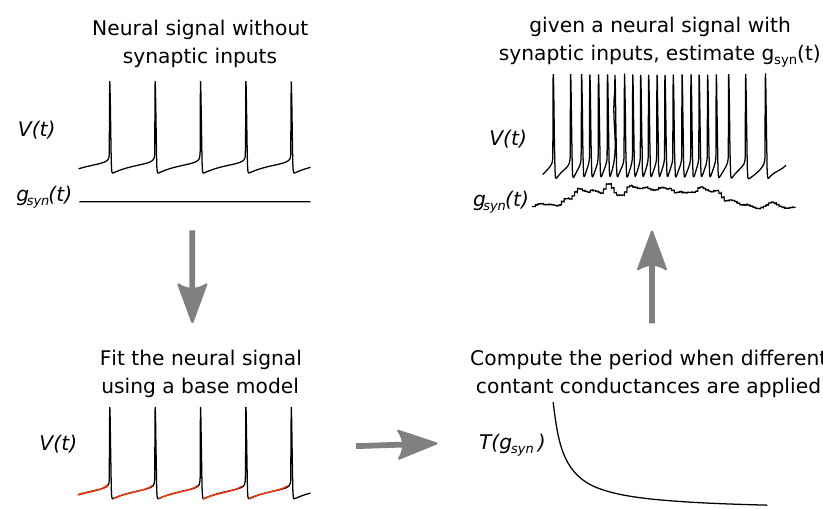
Figure 1. Scheme of the estimation procedure performed by Algorithm 1. Given a neural signal from a neuron which is not receiving synaptic inputs ( g syn ( t ) = 0; upper left ) but exhibiting regular spiking, we fit this signal using a computational model where the synaptic term is added afterwards ( bottom left , where the red color stands for the fitting). Next, we use this model to compute the period (or frequency) for different constant synaptic conductances ( T ( g syn ) , bottom right ). We finally estimate the synaptic conductance time course from a neural signal subjected to synaptic inputs ( upper right